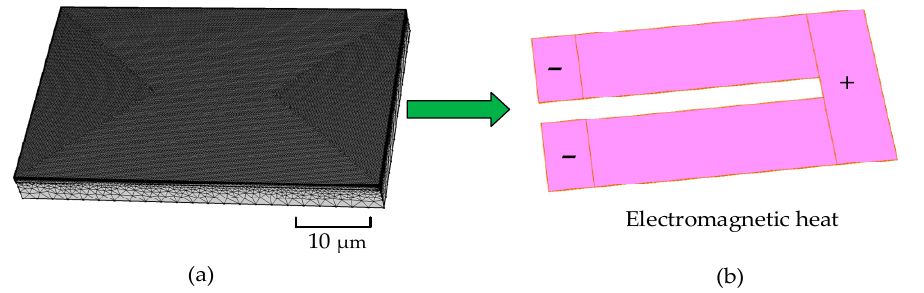
Figure 3. The physical field model of the TaN chopsticks-shaped heating resistors: ( a ) meshed 3D model of heating resistors; ( b ) electromagnetic heating model of the TaN film. Table 2. The main parameters of the materials during the simulation, t.